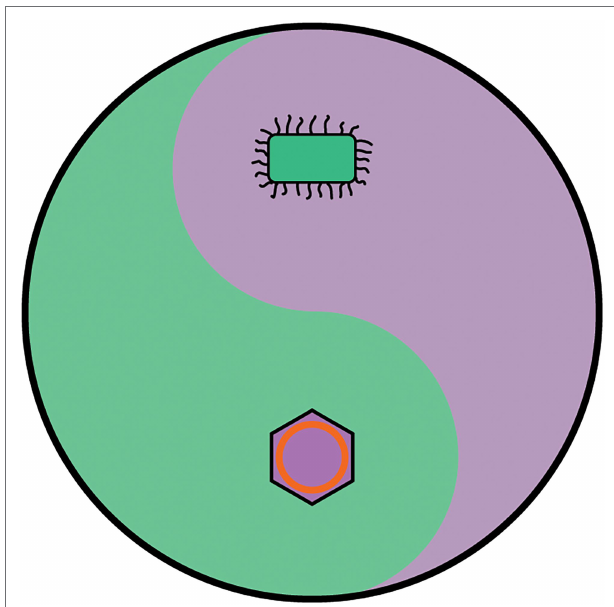
FIGURE 7 | The yin-yang metaphor for life. Organisms are defined as belonging either to the cellular domains or the viral hordes. The cellular domains include all members of the Bacterial, Archaeal and Eukaryotic domains, and are characterised by possessing DNA genomes which encode all the genetic information to construct functional ribosomes. The ability to synthesise proteins gives them a high degree of autonomy and allows them to encode all the enzymes and proteins to maintain and replicate a cell. The Viral hordes are composed of viruses, plasmids, transposons and retrotransposons and are characterised by being mobile genetic elements that are dependent of being in a cellular environment to display the features associated with life. The organisation and modes of evolution of the cellular domains and the viral hordes are of opposite nature, and yet are interdependent. Since viruses and cells may not be able to evolve without each other, it is anticipated that there have always been both these interdependent life forms since life began and may even have been characteristic of life before it evolved into recognisably modern